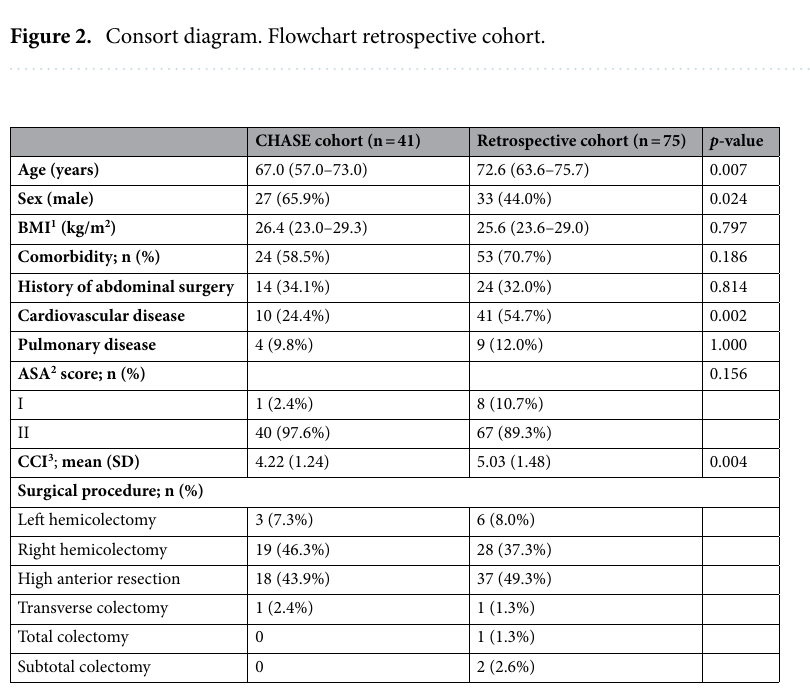
Table 2. Patient characteristics; median (interquartile range). 1 BMI body mass index; 2 ASA American Society of Anesthesiologists physical status classification system; 3 CCI Charlson Comorbidity Index score; SD: standard